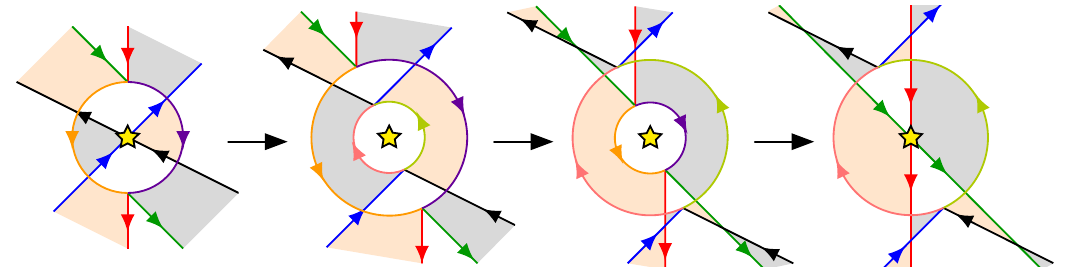
Figure 10. “Deconfinement duality” as seen from the brane tiling, which relates Q A to Q B ( M, G ) with the constraint φ = ( − 1) F = ( − 1) G + M . [Figure reproduced from [18] with USp